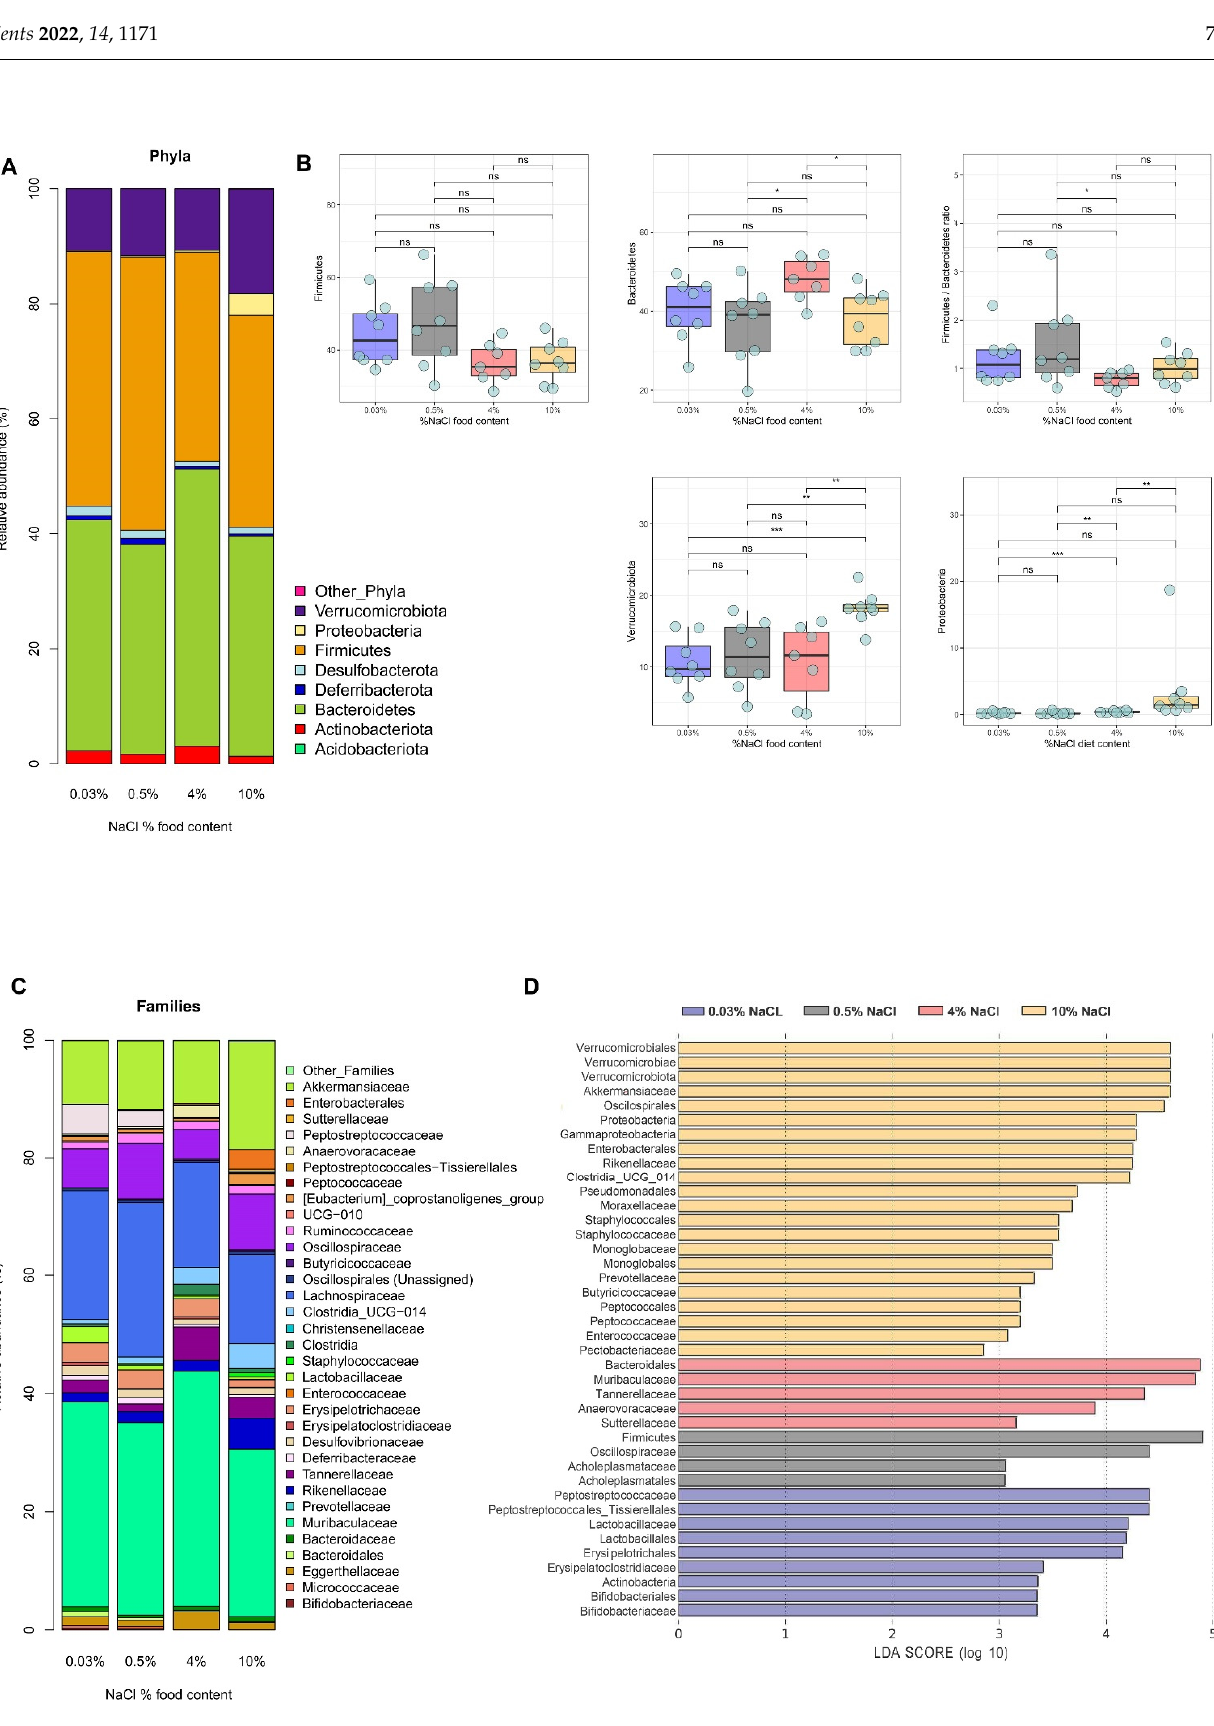
Figure 2. Alteration of microbiota induced by the HSD. Microbial taxonomic profiles from the fecal contents of mice fed on sodium ‐ deficient 0.03% NaCl, 0.5% NaCl (control), high salt 4% NaCl (HSD) and high salt 10% NaCl (HSD). ( A ) Fecal microbial profile at the phylum level. The X ‐ axis represents the group name, and the Y ‐ axis represents the relative abundance of each taxon. ( B ) Bacterial phyla